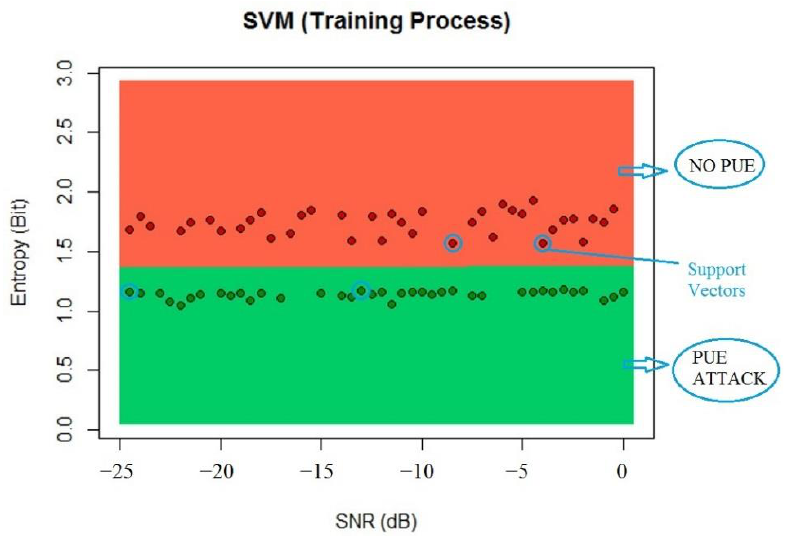
Figure 4. Example of SVM for PUE detection.